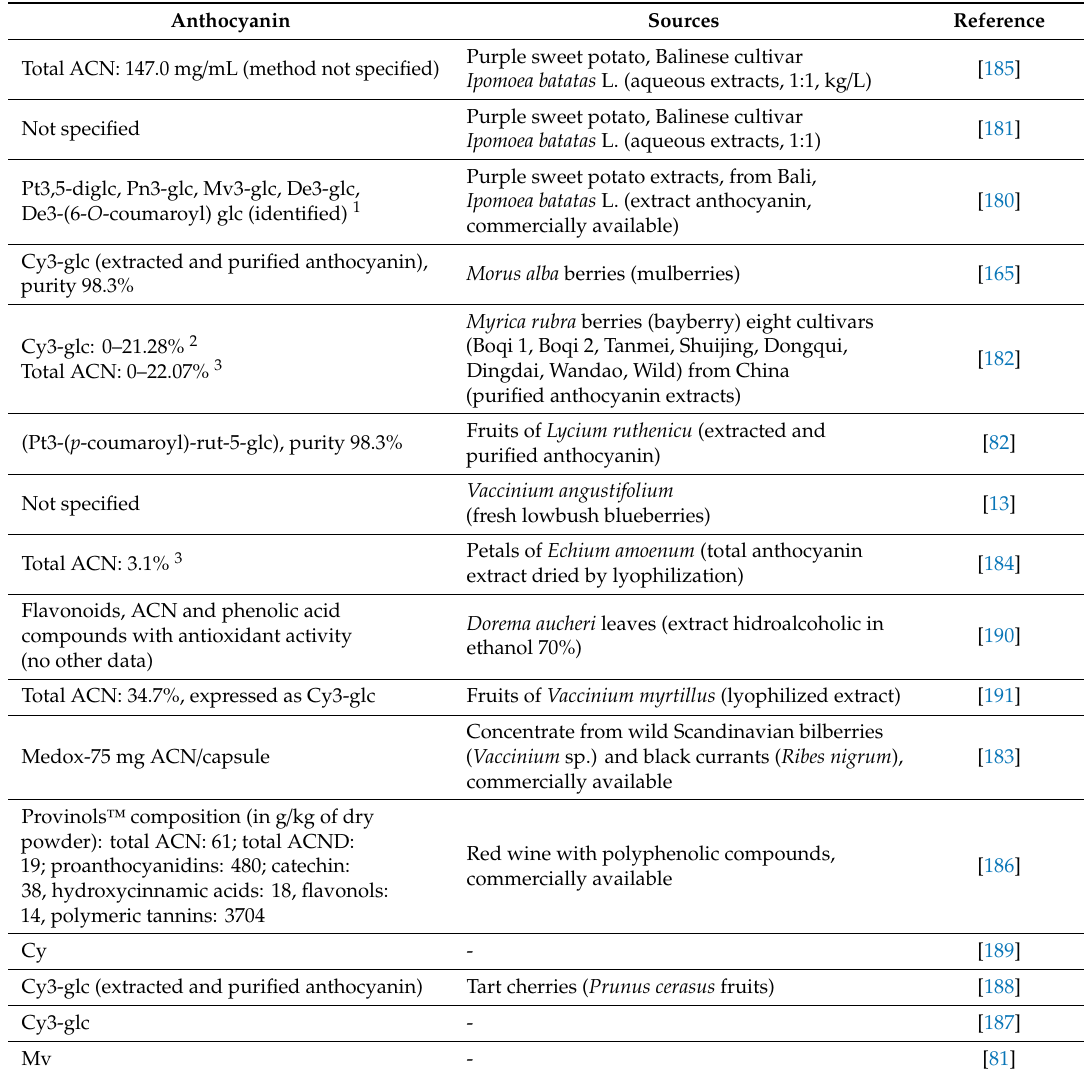
Table 4. Anthocyanins used in studies with experimental models of induced stroke. Anthocyanin Sources